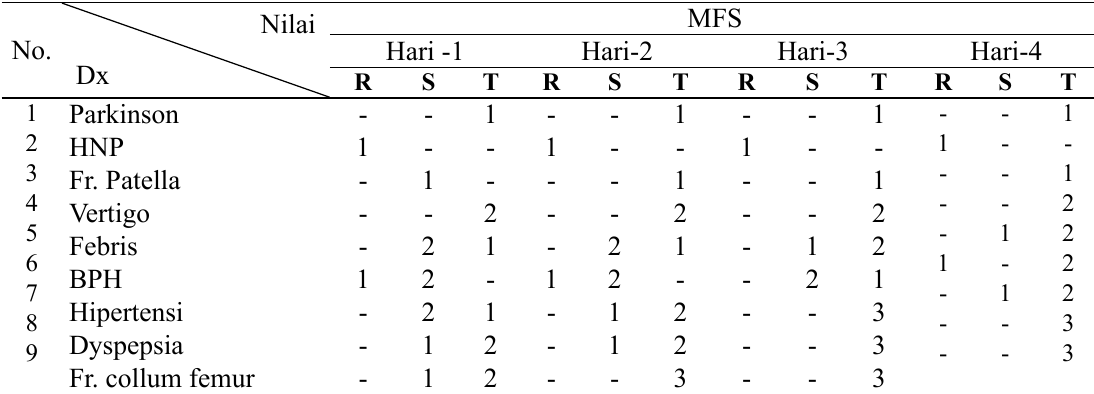
Tabel 7. Penilaian risiko jatuh dengan instrumen MFS berdasarkan diagnosis medis di ruang